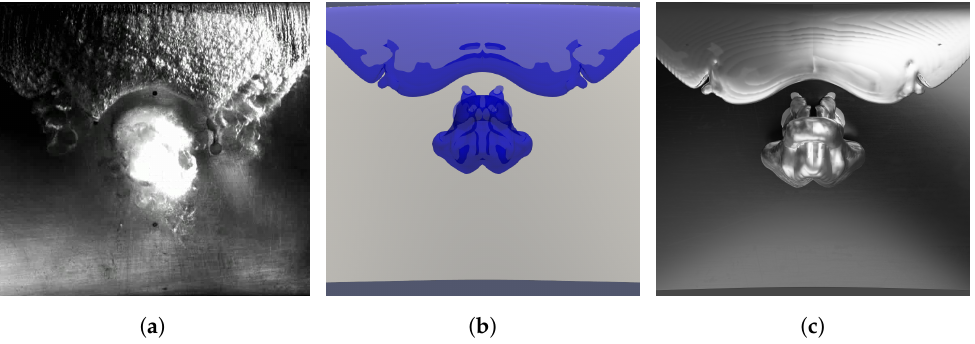
Figure 10. Suction side of the Delft Twist 11 hydrofoil exhibiting sheet vortex cavitation. ( a ) Ex- perimental, ( b ) ParaView, rasterisation, and ( c ) Blender, ray tracing. Flow is from top to bottom. Free-surface extracted using a vapour volume fraction iso-contour of